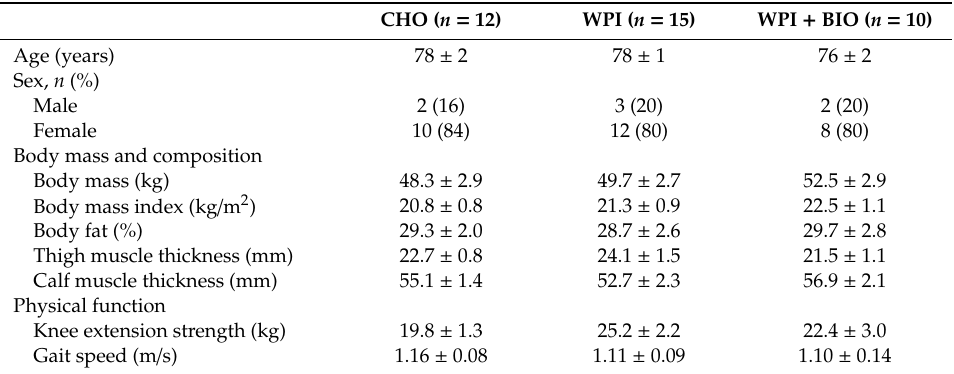
Figure 1. Flow of study participants: elderly subjects with limited mobility treated with a combination of electrical muscle stimulation (EMS) and nutritional supplement: CHO, WPI or WPI + BIO for 12 weeks. BIO: bioactives, CHO: carbohydrates, WPI: whey protein isolate. Table 1. Baseline characteristics of the elderly subjects with limited mobility treated with a combination of EMS and nutritional supplement: CHO, WPI or WPI + BIO for 12 weeks.